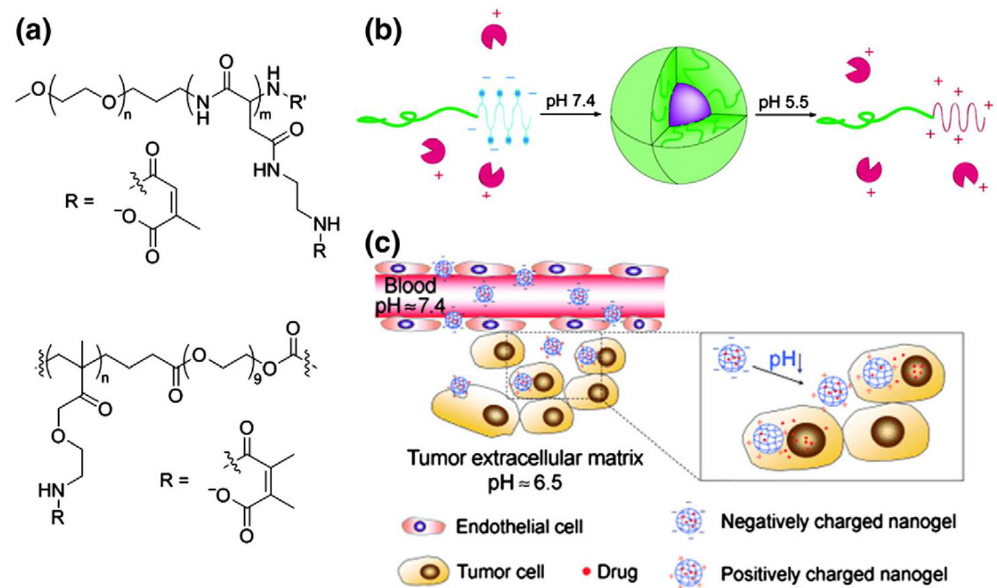
Figure 5. ( a ) Structure of a micellar charge-conversion nanocarrier (top) and a charge-conversion nanogel (bottom). ( b ) Formation and dissociation of a charge-conversion micelle encapsulating and releasing a positively-charged protein in dependence on the polymer charge. ( c ) Schematic illustration of the performance of the drug-loaded pH-responsive charge-conversion PAMA – DMMA nanogel. In the acidic tumor extracellular environment, the PAMA-DMMA nanogel is activated to be positively charged and is, thus, readily internalized by tumor cells with subsequent intracellular drug release. Reprinted from [44,45], with permission from John Wiley and Sons and American Chemical Society, respectively. Copyright (2010) WILEY-VCH Verlag GmbH & Co. KGaA, Weinheim and (2007) American Chemical Society.